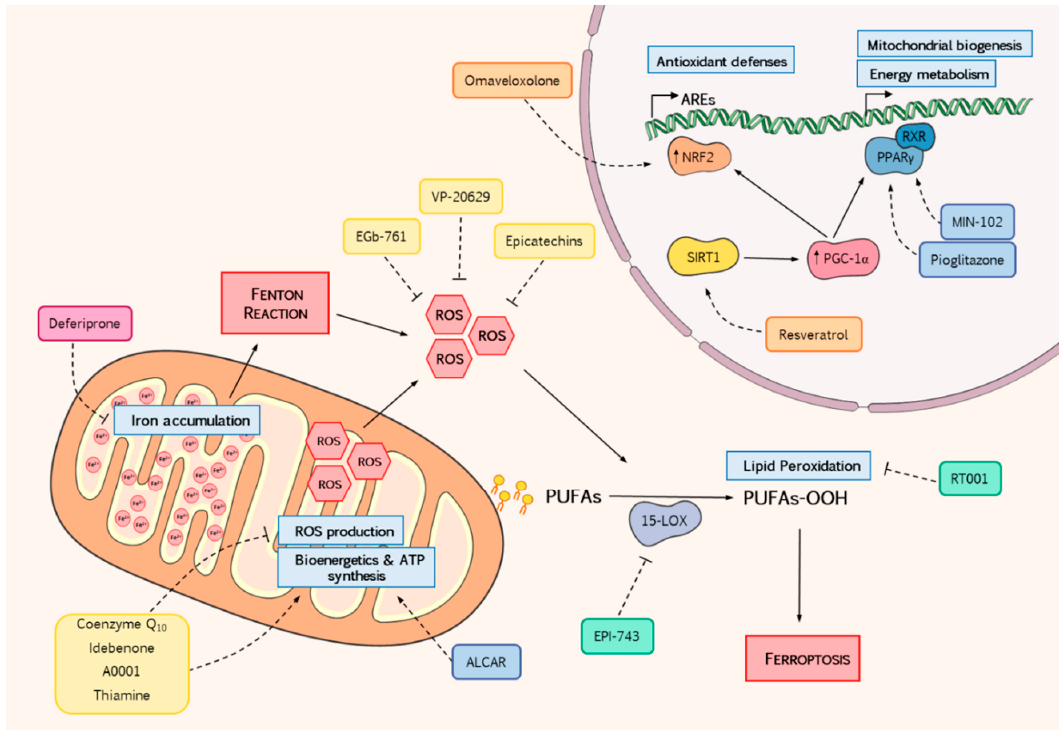
Figure 1. Schematic representation showing the defects associated with frataxin-deficiency that are